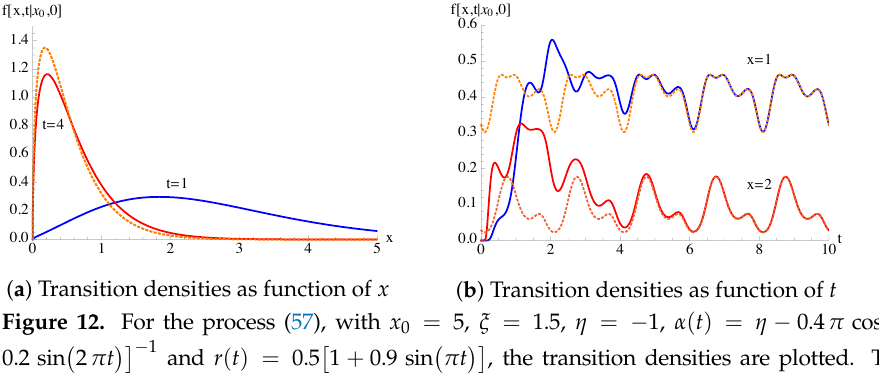
(cid:2) (cid:0) (cid:1)(cid:3) π t 1 + 0.9 sin , the transition densities are plotted. The dotted